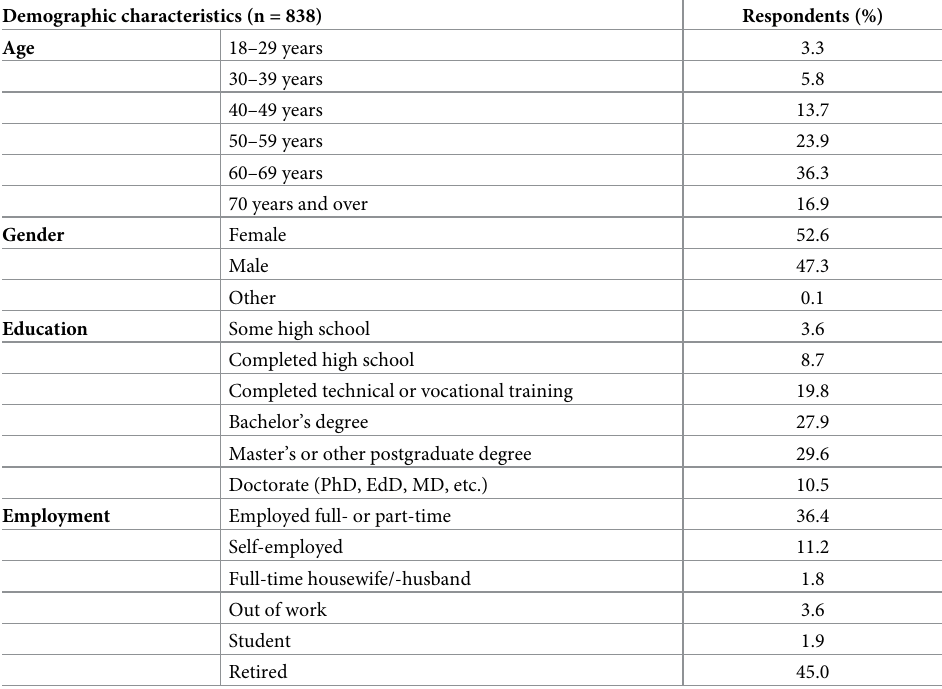
Table 1. Demographic characteristics of project participants who took part in the